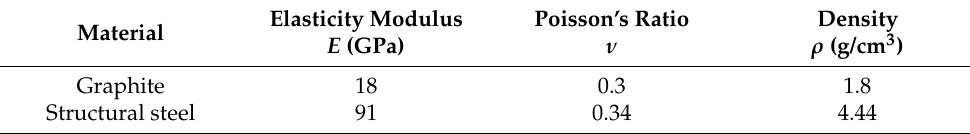
Table 2. Performance parameters of the inner rotor and the sealing